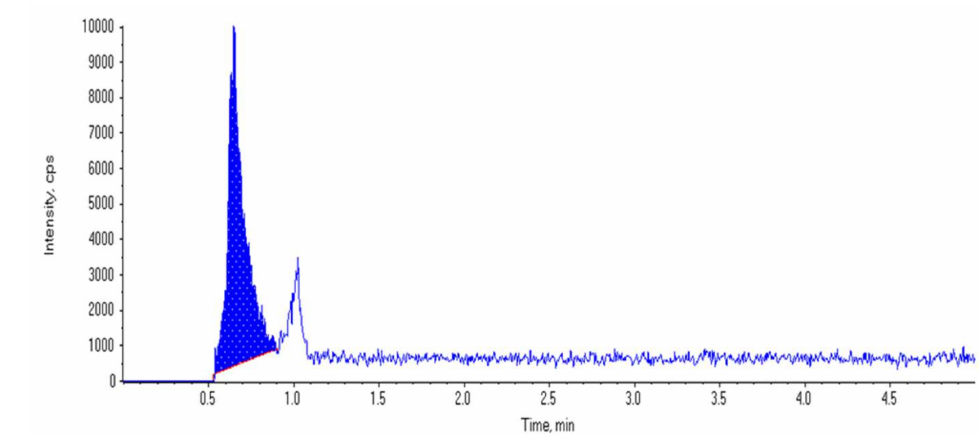
Figure 2. Chromatogram for detection of metformin standard with concentration 1.5 ug/mL. To create a calibration curve, serial dilutions of standards were made in a drug-free medium at concentrations ranging from 0.3 to 50 ug/mL for the metformin, and extraction was performed as stated in the sample preparation, as shown in Figure